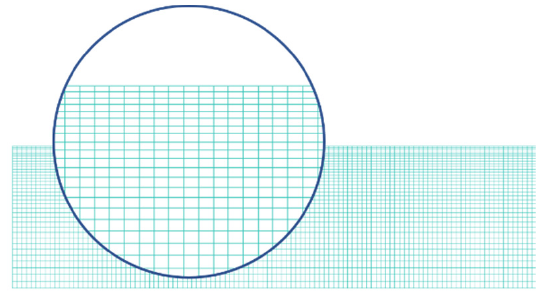
Figure 4. Local mesh structure.